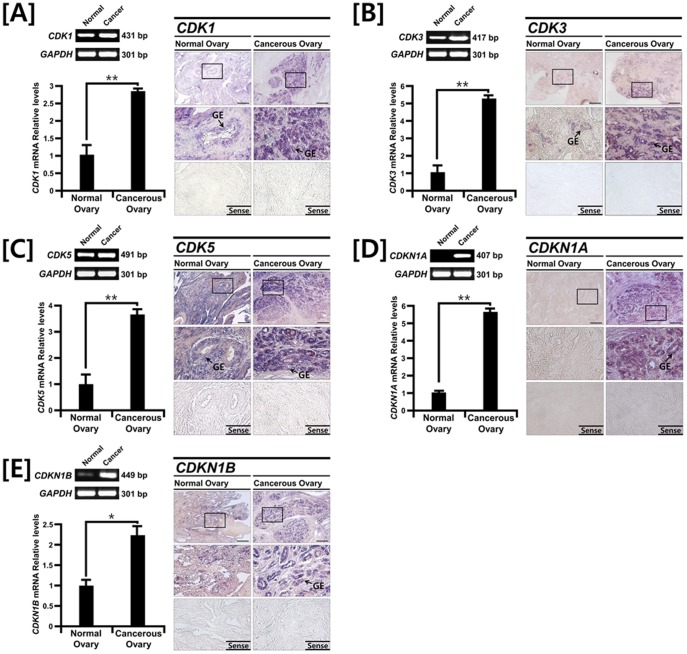
Comparative expression patterns for CDK1, CDK3, CDK5, CDKN1A and CDKN1B mRNAs in normal and cancerous ovaries from laying hens.RT-PCR and quantitative RT-PCR analyses were conducted using cDNA templates from normal and cancerous ovaries of laying hens with chicken CDK1, CDK3, CDK5, CDKN1A and CDKN1B and chicken GAPDH specific primers (left panel). These experiments were conducted in triplicate and normalized to values for GAPDH. In situ hybridization analysis indicates cell specific expression patterns of CDK1, CDK3, CDK5, CDKN1A and CDKN1B mRNAs both normal and cancerous ovaries from laying hens (right panel). See Materials and Methods for complete description.